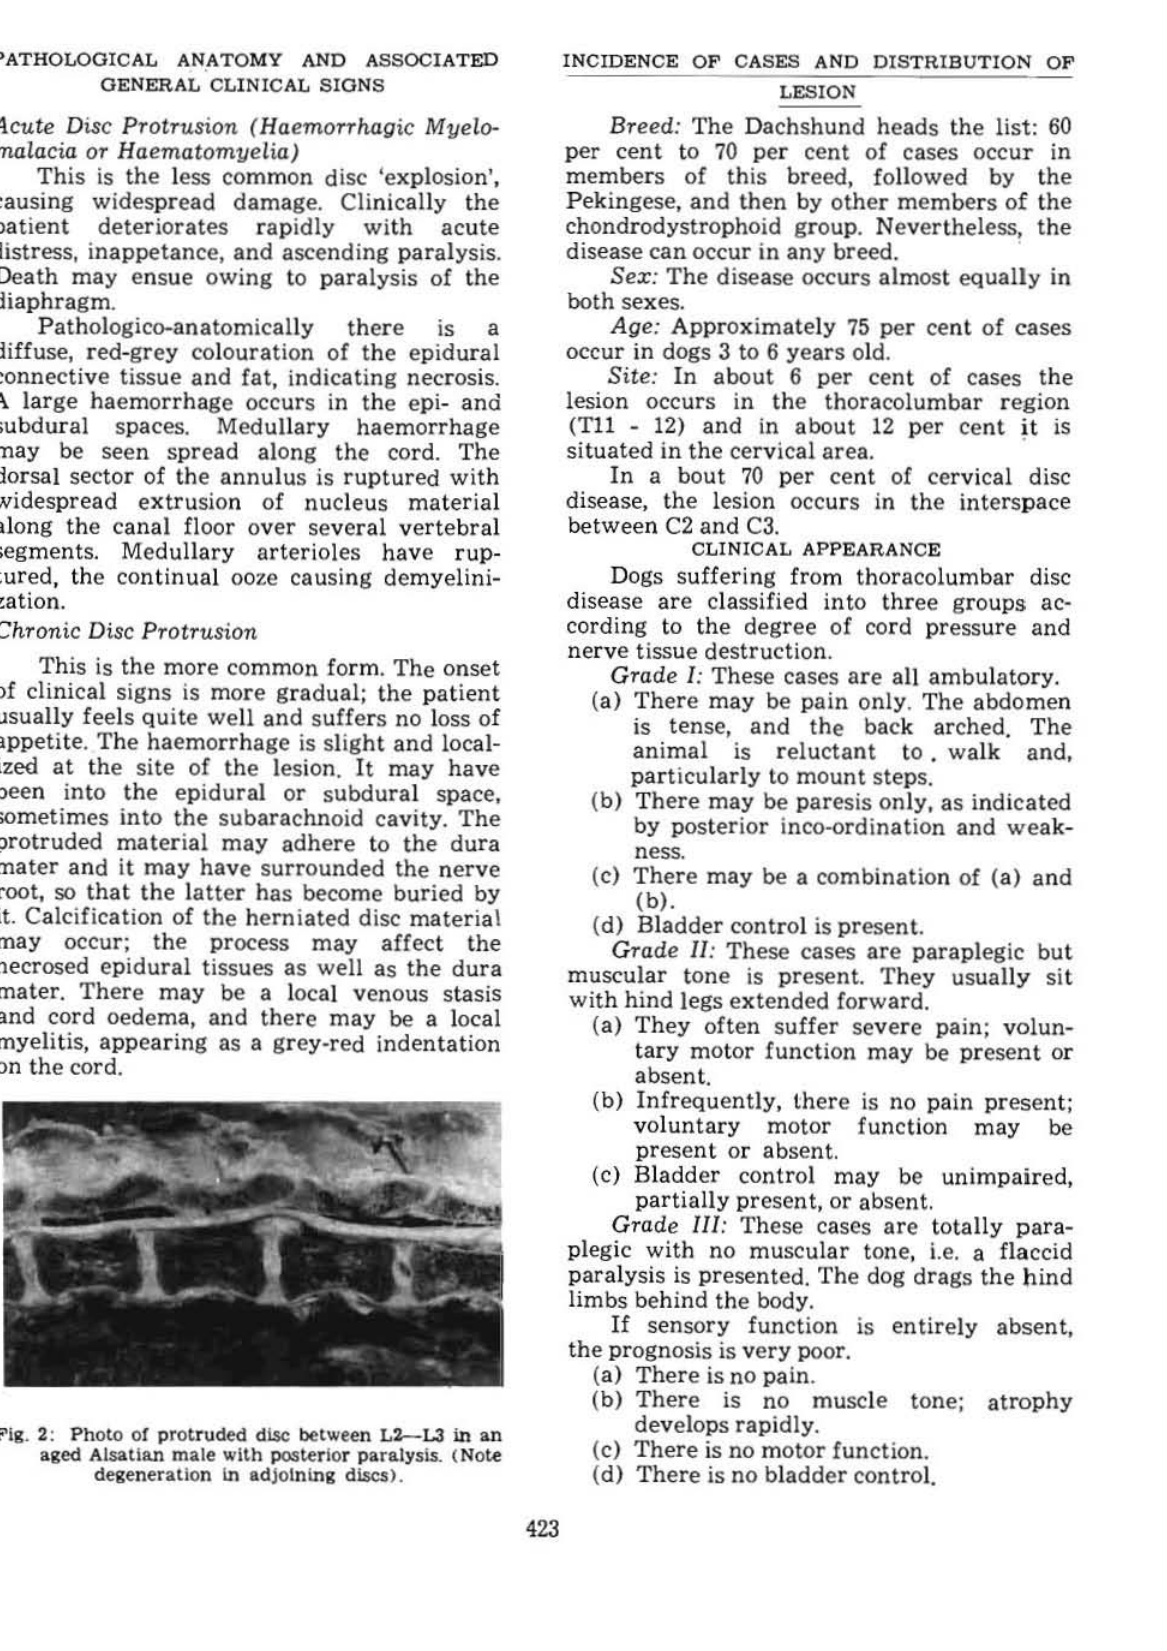
Fig. 2: Photo of protruded di.$e between L2-L3 in an aged Alsalla.n male with posterior paralysis. (Note degeneration In adjoining